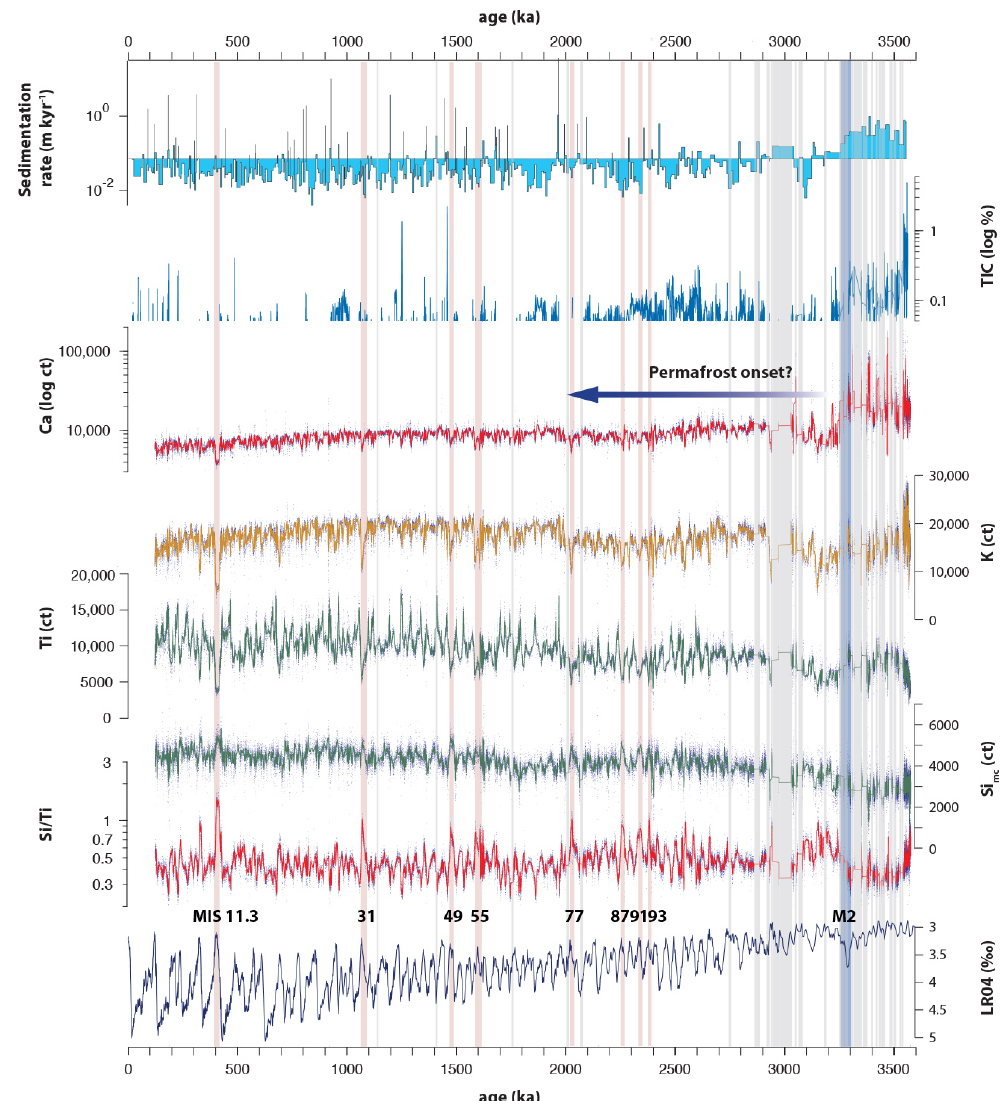
Figure 3. Matrix-corrected Si intensity (Si mc ) , Si/Ti ratios, K, Ti, and Ca intensity determined by XRF core scanning as well total inorganic carbon (TIC) content and sedimentation rate in the sediment record from Lake El’gygytgyn vs. age compared with the LR04 global marine isotope stack. XRF data are plotted as raw data (blue dots) and 101-point weighted running average (colored lines). “Super-interglacials” at Lake El’gygytgyn and the mid-Pliocene M2 cooling event are highlighted with red and blue bars, respectively. Gaps in the record are shaded with grey bars. Please note the logarithmic scaling of the Ca